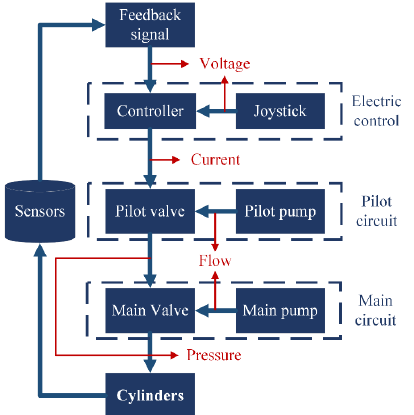
Figure 4. The signal transmission diagram of electro-hydraulic system.